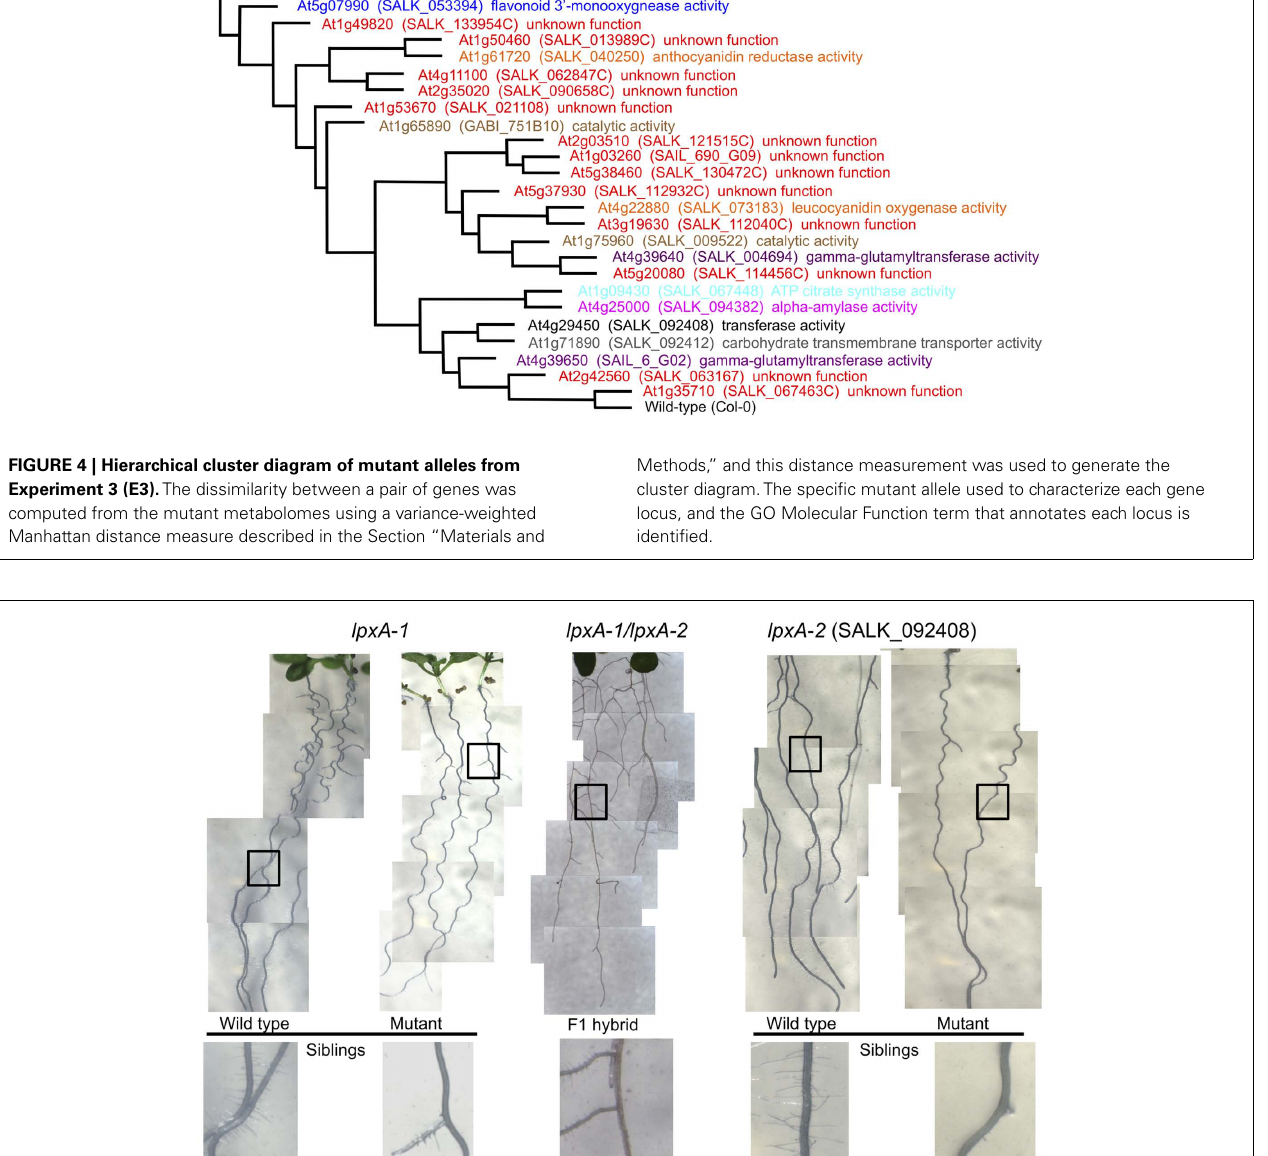
FIGURE 5 | Root phenotype analysis of lpxA-1 and lpxA-2 (SALK_092408) alleles. The heteroallelic cross of lpxA-1 and lpxA-2 (middle) recapitulates the loss of root hair